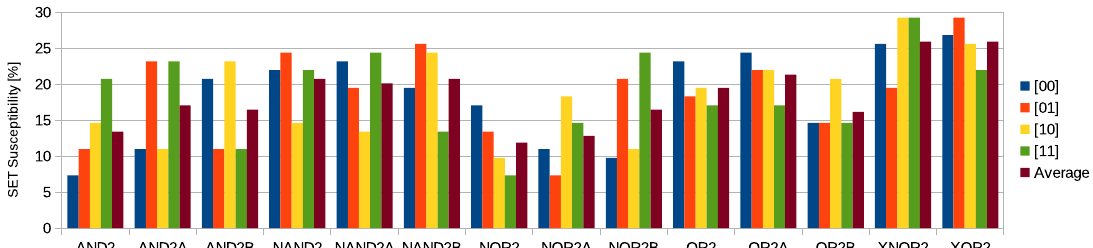
Figure 5. SET susceptibilities of the 2-input combinational functions. For each macro, it presents the susceptibility for each input pattern and their average